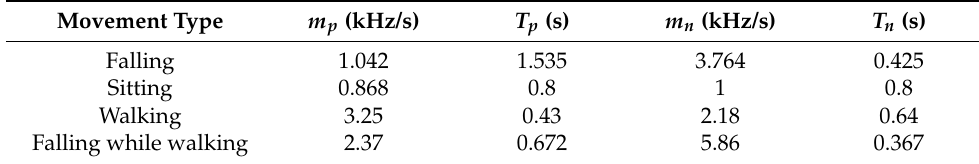
Table 2. Movement